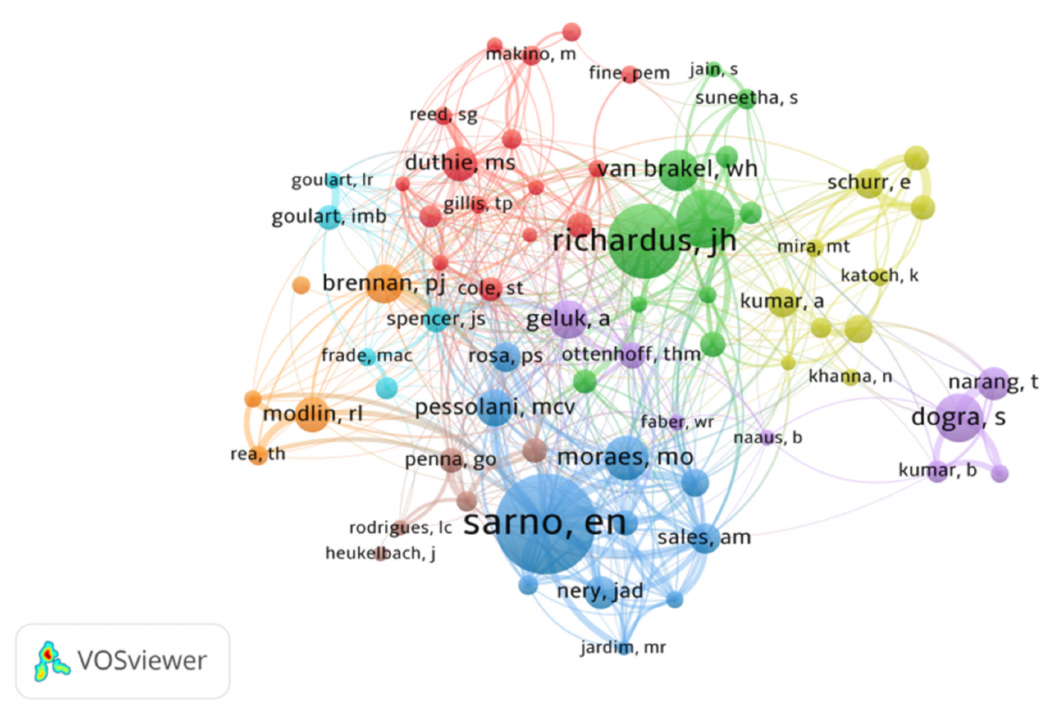
Figure 3. A collaborative network of co-authors in the field of leprosy (2000–2021).